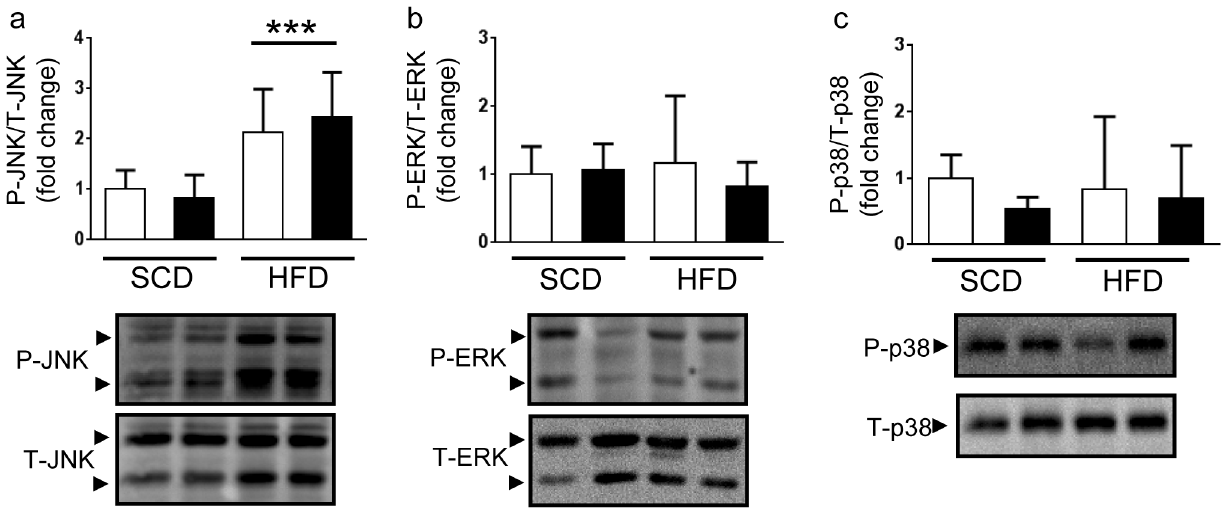
Figure 6. MAPK analysis in epididymal adipose tissue. JNK ( a ), ERK ( b ) and p38 ( c ) phosphorylation status in epididymal adipose tissue of male mice. ***p , 0.005 Main Effect SCD vs. HFD. Data are mean 6 SD. White bars are wt mice, black bars are dusp2 2 / 2 mice. Ns are 5, 7, 8 and 8 for wt SCD, dusp2 2 / 2 SCD, wt HFD and dusp2 2 / 2 HFD, respectively.